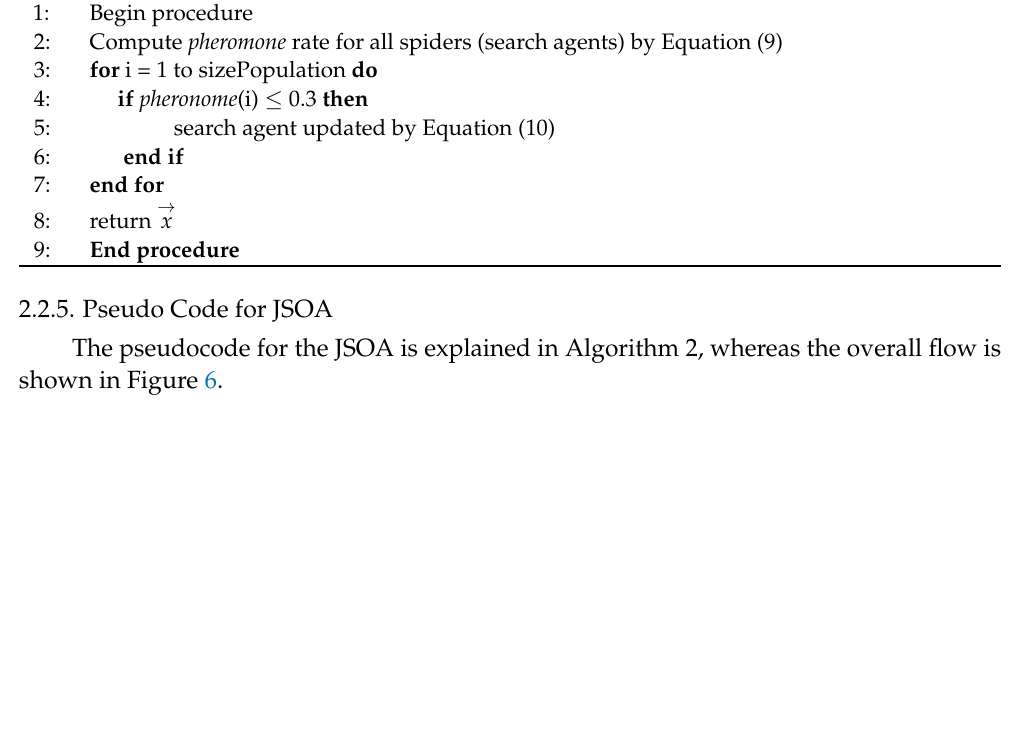
Algorithm 1 Pheromone